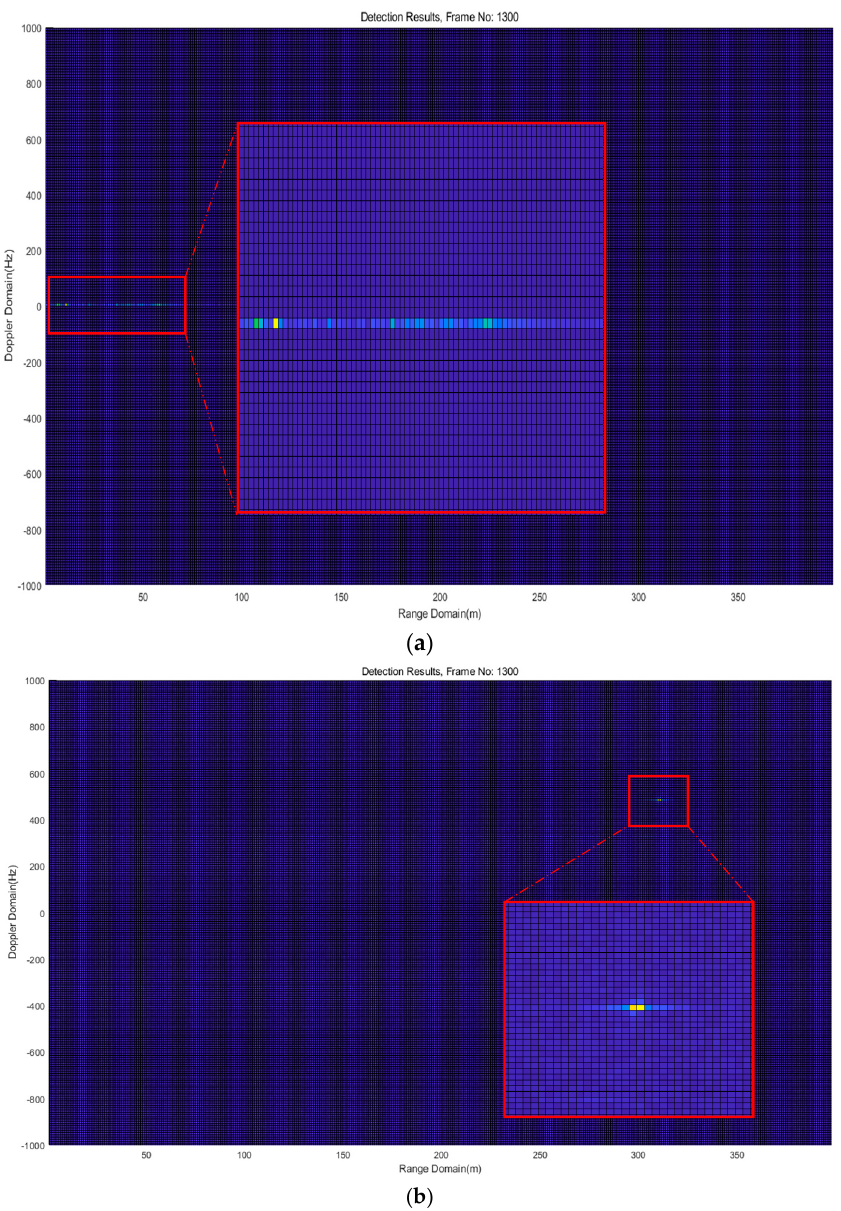
Figure 16. Illustration of the detection results, ( a ) without the clutter mitigation approach; and ( b ) with the clutter mitigation approach.